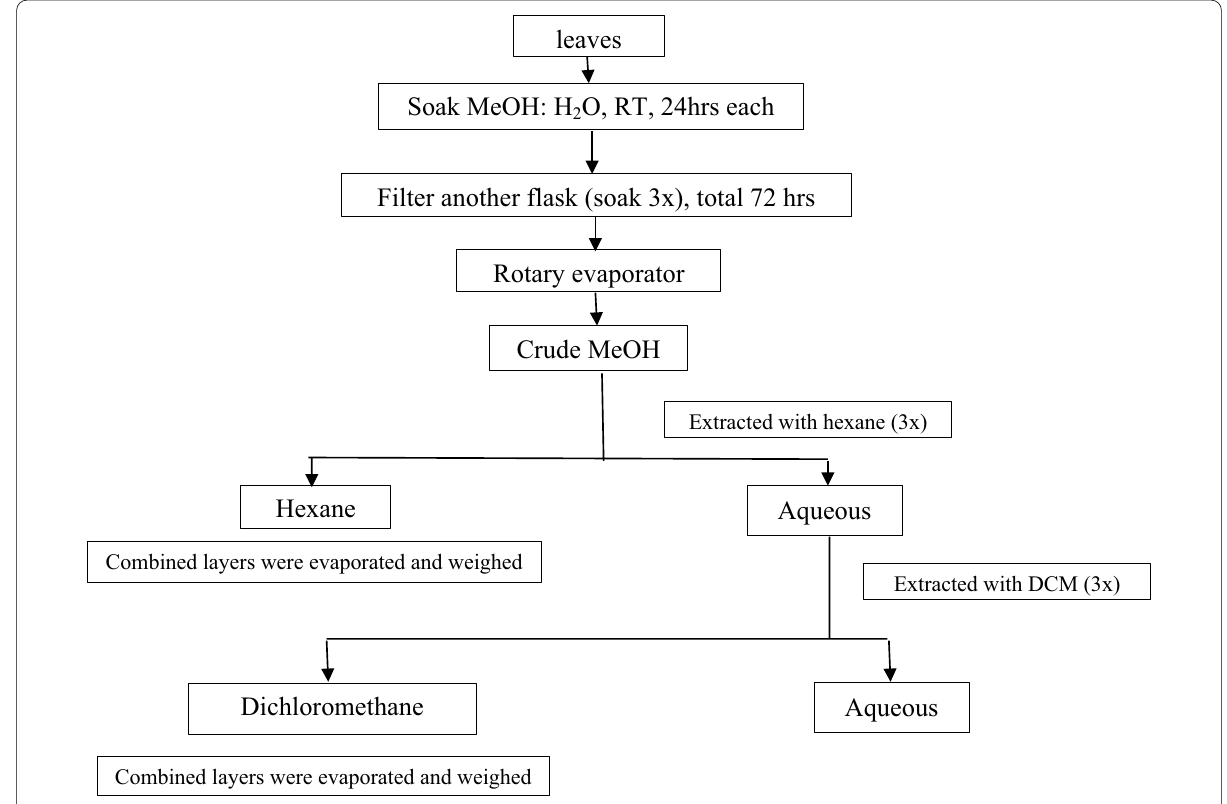
Fig. 1 Liquid–liquid extraction with solvent extraction and partitioning of Clinacanthus nutans